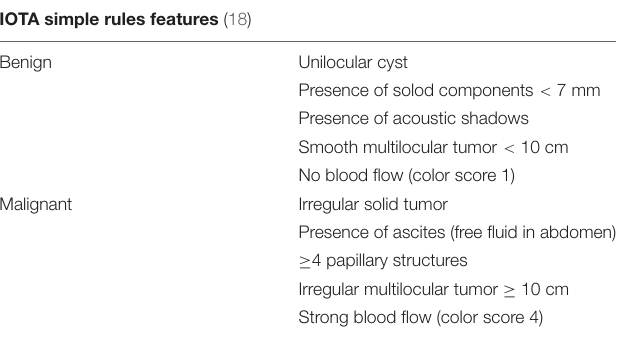
TABLE 1 | A list of the IOTA Simple Rules ultrasonography features for classifying pelvic masses. IOTA simple rules features